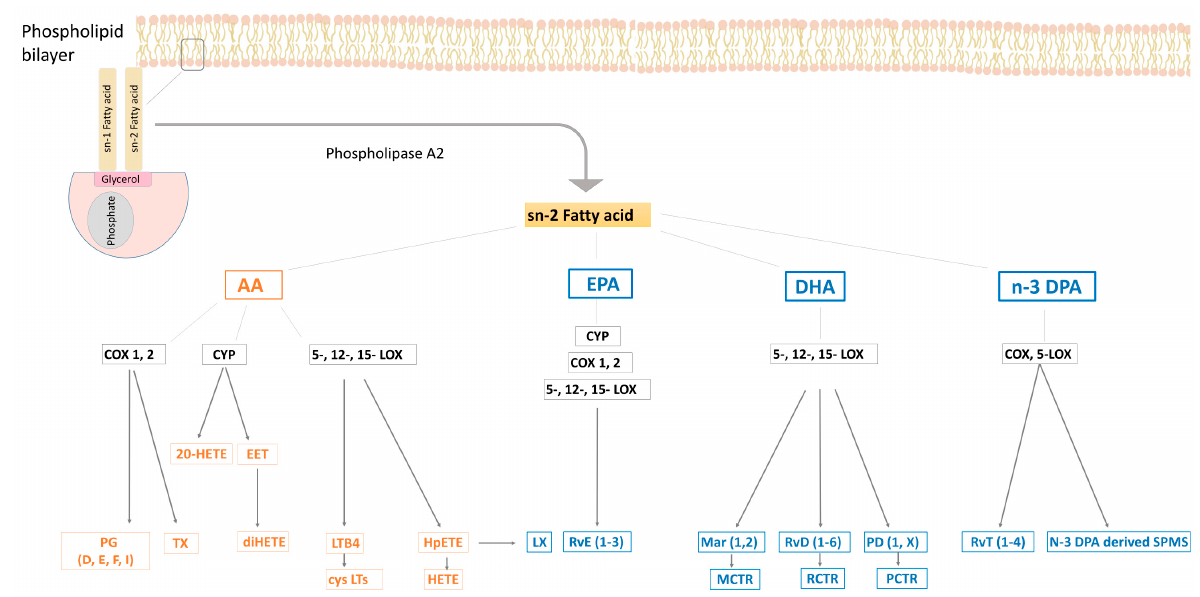
Figure 2. Metabolic pathways for n-6 (orange) and n-3 (blue) polyunsaturated fatty acids. COX, cyclooxygenase; CYP, cytochrome P450; CysLTs, cysteinyl leukotrienes; DHA, docosahexaenoic acid; DPA, docosapentaenoic acid; EET, epoxyeicosatetraenoic acid; EPA, eicosapentaenoic acid; HETE, hydroxy eicosatetraenoic acid; HpETE, hydroperoxy eicosatetraenoic acid; LTB4, leukotriene B4; LOX, lipoxygenase; LX, lipoxin; MaR, maresin; MCTR1, maresin conjugates in tissue regeneration 1; PCTR, protectin conjugates in tissue regeneration; PD, protectins; PG, prostaglandin; RvD, D-series resolvin; RvE, E-series resolvin; RvT, thirteen-series resolvin; Tx, thromboxane. TxA 2 ), whereas series 1 PGs (PGD 1 , PGE 1 , and TxA 1 ) and series 3 PGs (PGD 3 , PGE 3